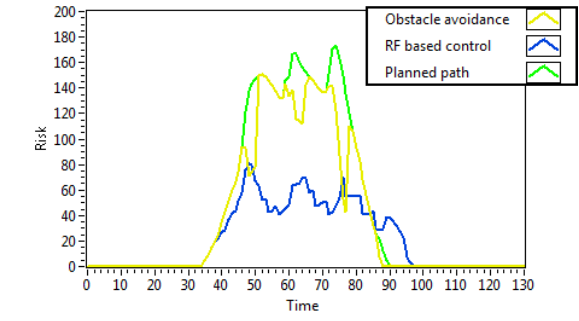
Figure 10: Risk through time for the different